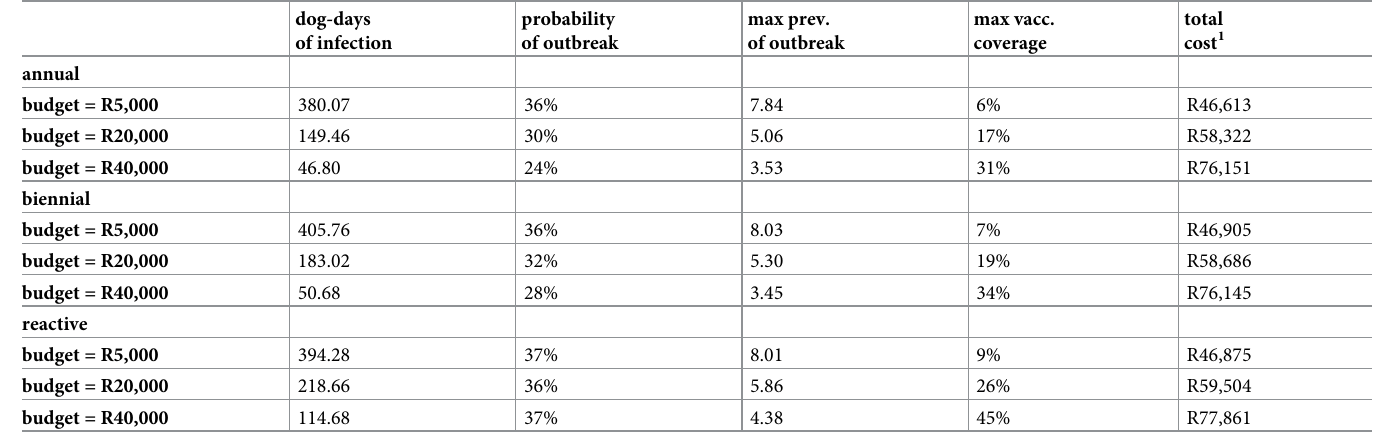
Table 5. Vaccination and female sterilization